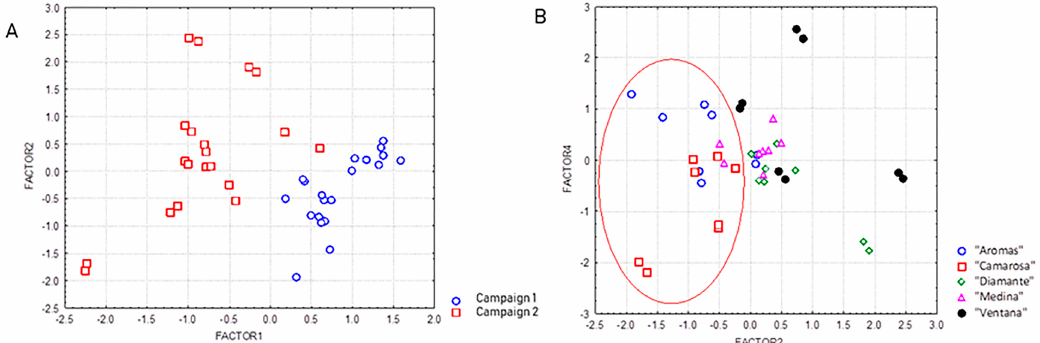
Figure 1. Principal component analysis (PCA) score plots showing the projection of strawberry samples in the plane defined by the following principal components: ( A ) PC1 vs. PC2, separation of samples according to the campaign; ( B ) PC2 vs. PC4, separation of samples according to the cultivar.